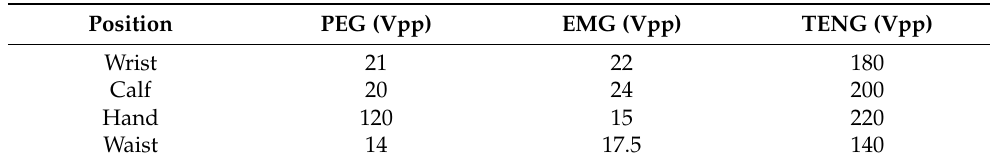
Figure 7. Practical implementation of the hybrid generator to harvest the human activity energy on various body parts: ( a ) wrist; ( b ) hand; ( c ) calf; ( d ) waist. Table 1. Output voltage generated from each wearing position (Vpp is the peak-to-peak voltage in